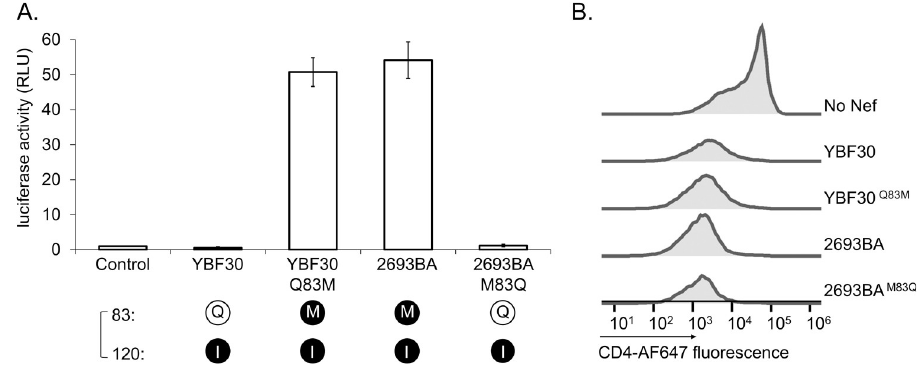
Fig 4. Role of residue 83/120 pairing in the HIV-1 N Nef R-clamp. (A) HZ-1 cells were transfected with an AP- 1-dependent luciferase reporter alone (Control) or together with wild type (WT) versions of YBF30 or 2693BA Nef, or mutants thereof carrying reciprocal amino acid changes of residue 83 (YBF30 Q83M and 2693BA M83Q). Luciferase activity was measured from cells 4 h post-transfection, and normalized to the corresponding control sample that was set to one. The data shown are derived from three independent experiments, with SE indicated by error bars. The amino acid combinations at positions 83 and 120 are indicated here and in the figures below as single-letter symbols and color-coded according to the residue classification shown in Table 1. Specifically, small (G or A) or hydrophilic residues (D, E, Q, or S) at position 83 are shown as a black 1-letter symbol in a white sphere (here Q83 in YBF30), whereas aliphatic or methionine residues at this position are shown as a white letter in a black sphere (here M83 in 2693BA). At position 120, aromatic residues (F or Y) are shown as a black letter in a white sphere (not found in YBF30 or 2693BA), whereas isoleucine is shown as a white letter in a black sphere (here I120 in YBF30 and 2693BA). (B) CD4 downregulation by Nef in stably transduced Jurkat T cells was examined as in Fig 1C. Original dot plots are shown in S2 Fig.